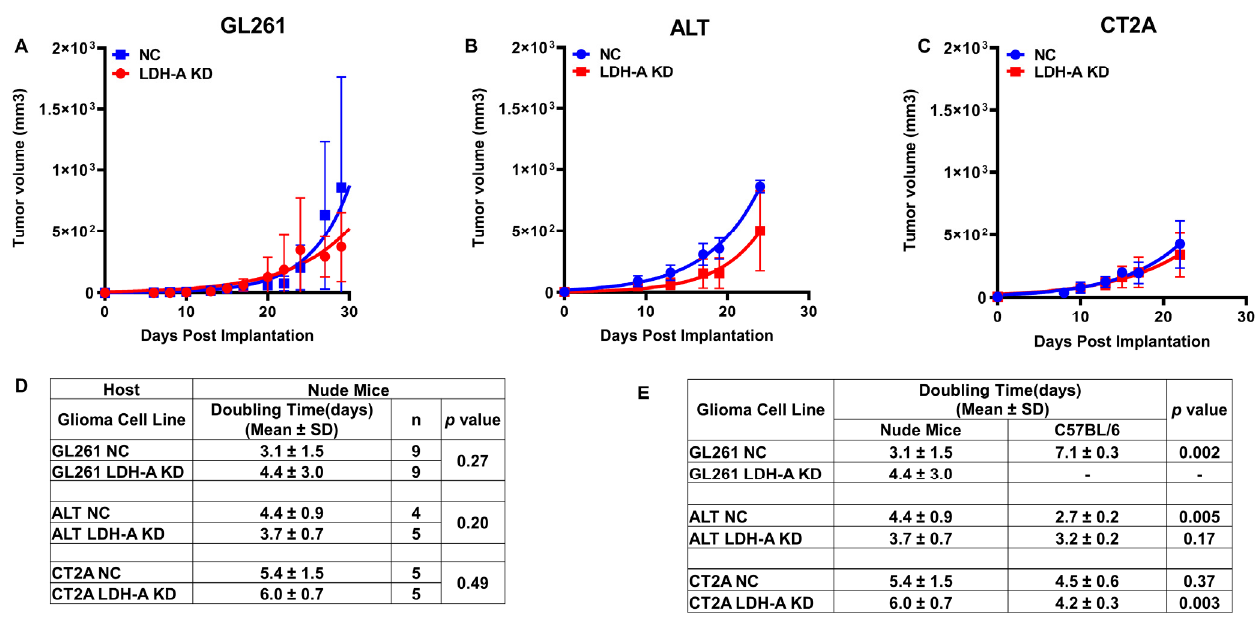
Figure 5. The effect of LDH-A knock-down on s.c. tumor growth in nude mice . Growth profiles of GL261, ALTS1C1 and CT2A tumors (Panels A – C ), and estimated tumor doubling times (Panel D ). Mean, ± SD. Comparison between tumor doubling times in nude mice and C57BL/6 mice (Panel E ).